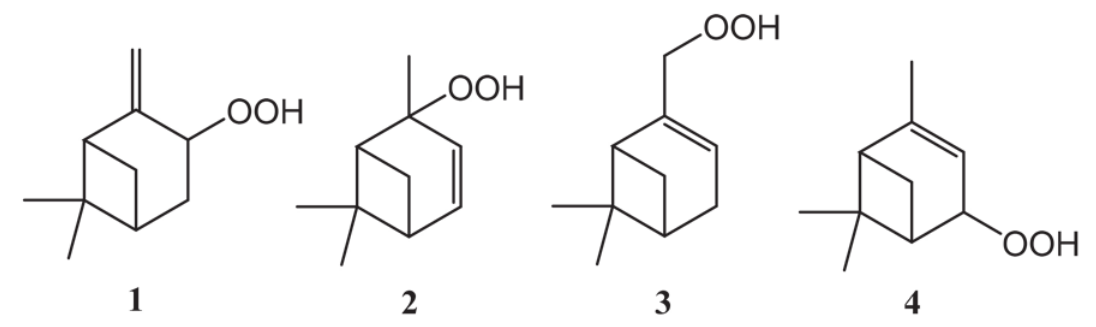
Figure 1. Structures of the hydroperoxides studied: pinocarvyl-hydroperoxide 1, 4-hydroperoxy-4,6,6-trimethylbicyclo[3.1.1]hept-2-ene 2, myrte- nyl-hydroperoxide 3 and verbenyl-hydroperoxide